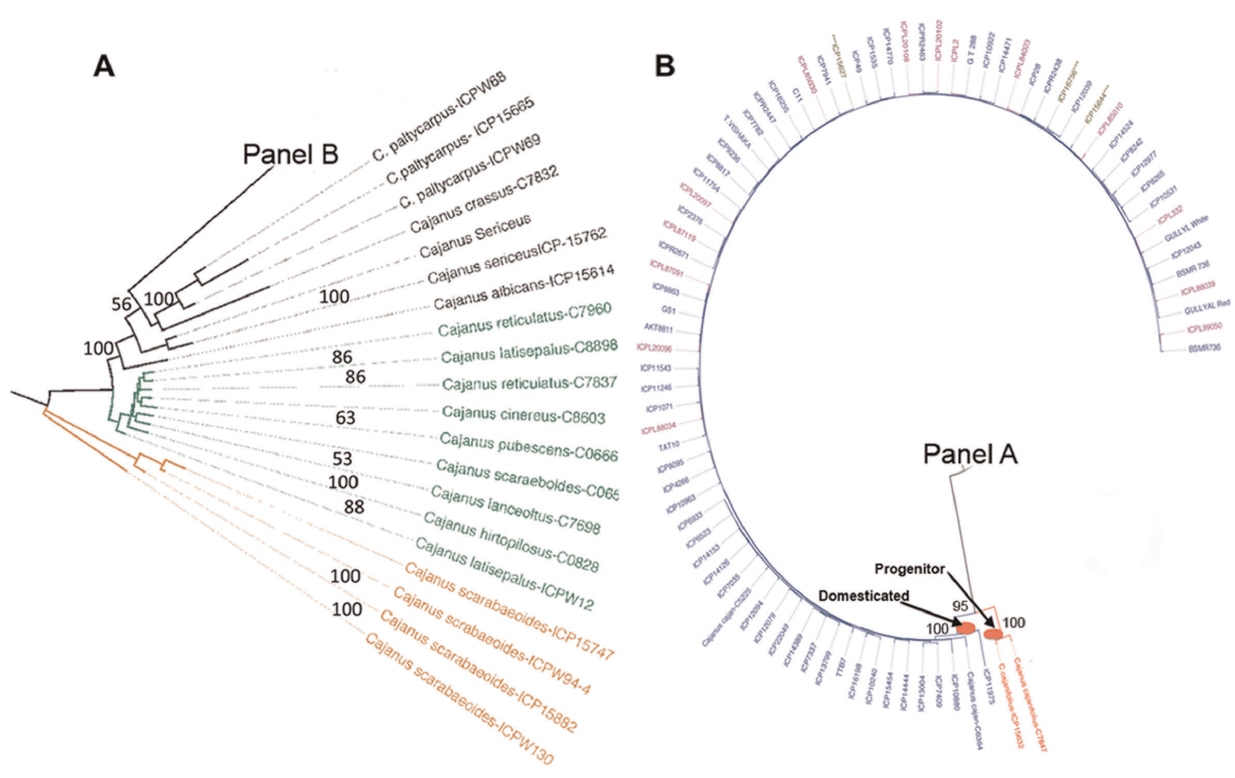
Figure 1. Neighbor Joining phylograms depicting wild and domesticated pigeonpea. Panel A , relationships among wild Cajanus species. Species groups are designated by color: orange, Wild -Scarabaeoides ; green, Wild-Australia; black, Wild-India. Panel B , expansion of domesticated lineages from Panel A. The nature of accessions is reflected in their colors: red, wild progenitor; blue, cultivars and genebank accessions; pink, landraces. *** indicates mislabeled accessions annotated as wild species. The two Neighbor-Joining trees are linked to each other at Panel B and Panel A respectively. Bootstrap values of $ 50% are shown above their respective branches.